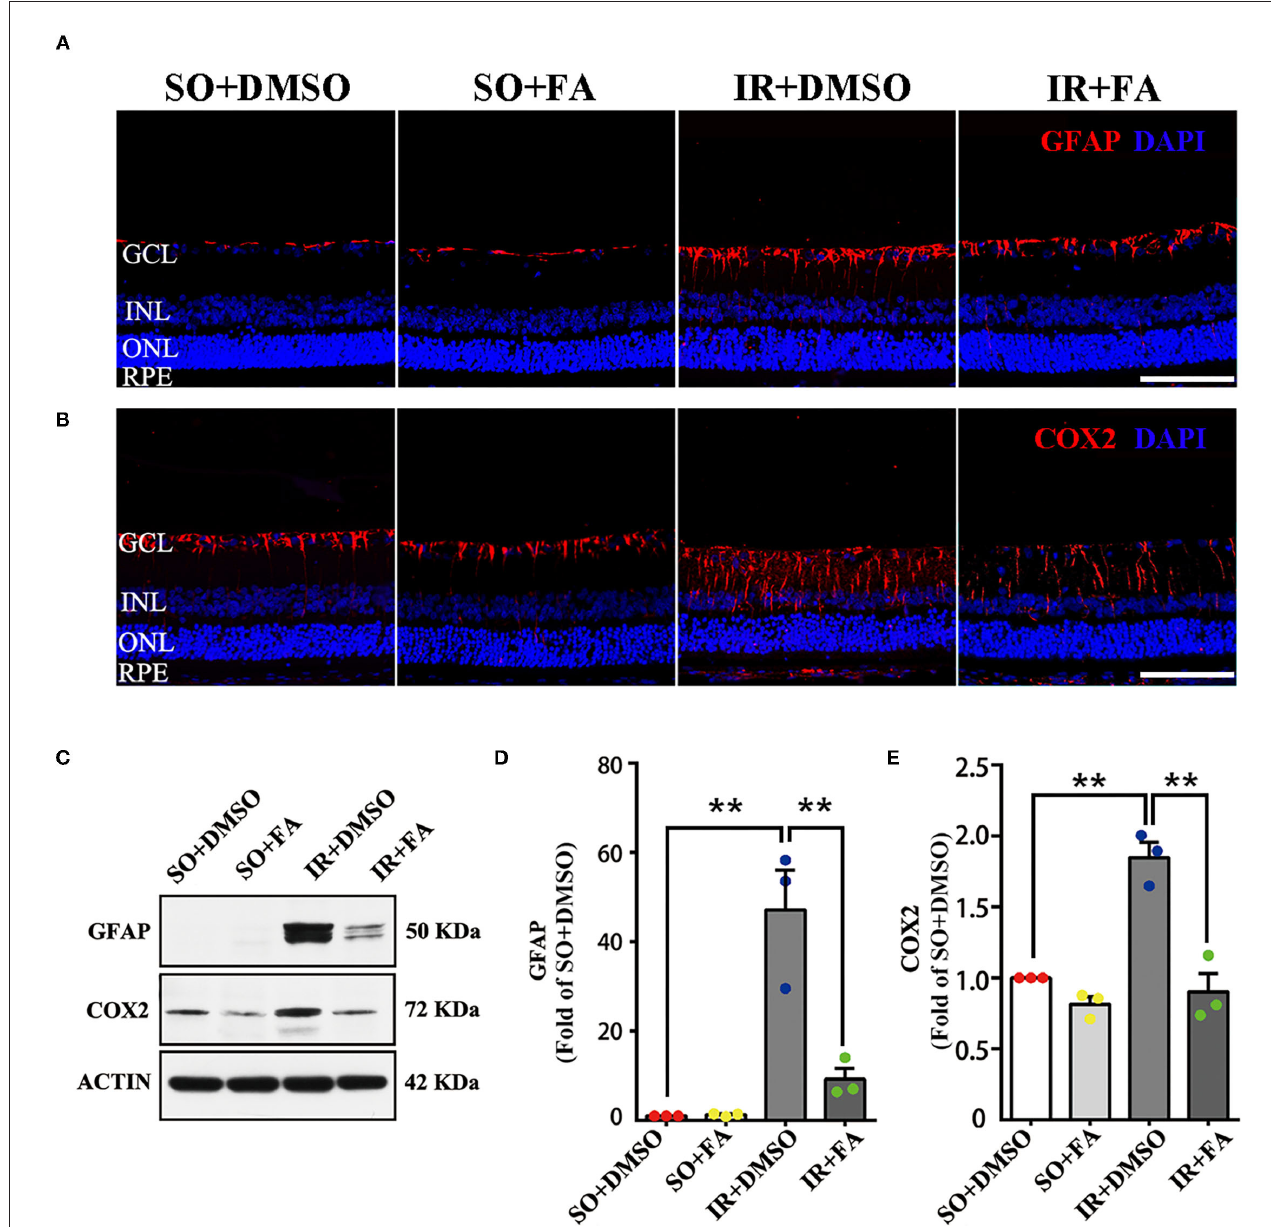
FIGURE 6 | Activation of PPAR α by FA repressed GFAP and COX2 expression in the retinas of IR rats. (A,B) Representative photomicrographs of immunostained GFAP/COX2 (red) and nuclei (blue; counterstained by DAPI) in retinal sections at 24h post-modeling. (C) Retinal expression of GFAP, COX2, and actin detected by western blotting. (D,E) Average expression of GFAP/COX2 semi-quantified by densitometry and normalized by actin levels in retinas. Data are the mean ± SEM; ** p < 0.01. Scale bar = 50 µ m.